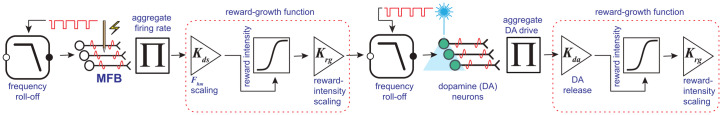
The series-circuit model.The boxed low-pass filter symbols represent the frequency-following functions that map the electrical pulse-frequency into the induced frequency of firing in the directly stimulated neurons subserving eICSS or the optical pulse-frequency into the induced frequency of firing in the dopamine neurons subserving oICSS. The reward-growth functions are shown here as S-shaped, which is the form they describe when plotted in linear or semi-logarithmic (reward intensity versus log(pulse frequency)) coordinates. Kds (ds stands for “directly stimulated”) scales the input to the reward-growth function for eICSS, whereas Kda scales the input to the reward-growth function for oICSS. Krg scales the output of the reward-growth functions. According to this model, the rewarding effects produced by both electrical stimulation of medial-forebrain-bundle (MFB) neurons and optical stimulation of midbrain dopamine neurons have a common cause: activation of midbrain dopamine neurons. This activation is due to transsynaptic excitation in the case of eICSS and direct excitation in the case of oICSS. The results of prior eICSS studies [34, 39, 47] require that drugs that perturb dopaminergic neurotransmission alter the computation of reward intensity by actions downstream from the output of a logistic reward-growth function (leftmost box containing an S-shaped curve). The results of the present study require that a similar reward-growth function lies downstream from the dopamine neurons (rightmost box containing an S-shaped curve). We show below that the placement of this second reward-growth function is incompatible with the eICSS data.